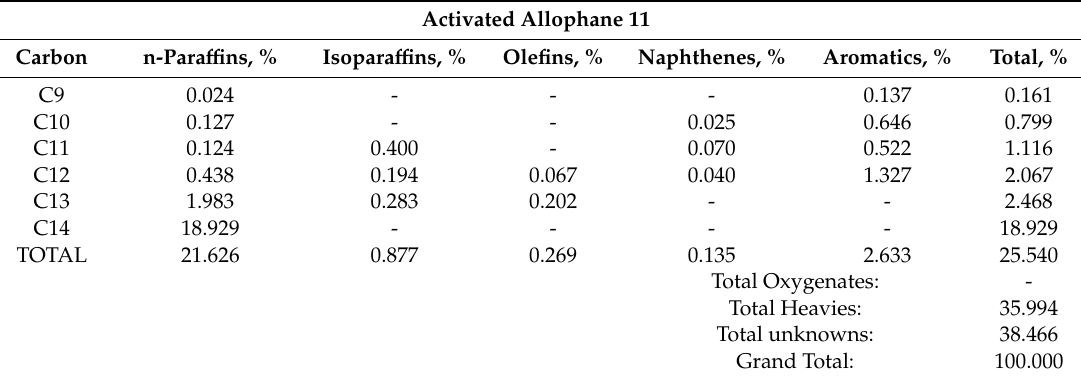
Table 25. Total composition results by group type and carbon number, as a percentage of the mass of activated allophane